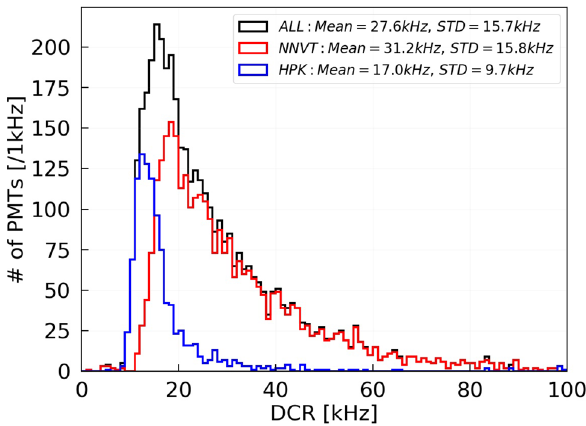
Fig. 46 DCR of potted PMTs at a gain of 1 × 10 7 , measured in con- tainers #A and #B. Black: all PMTs; blue: HPK; and red: